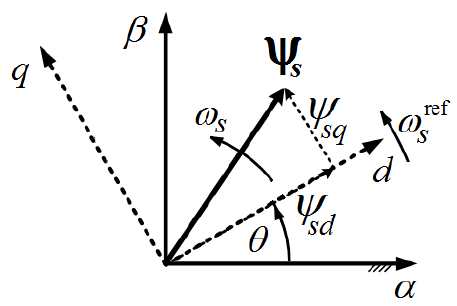
Figure 3. Voltage vector in a synchronous reference frame.